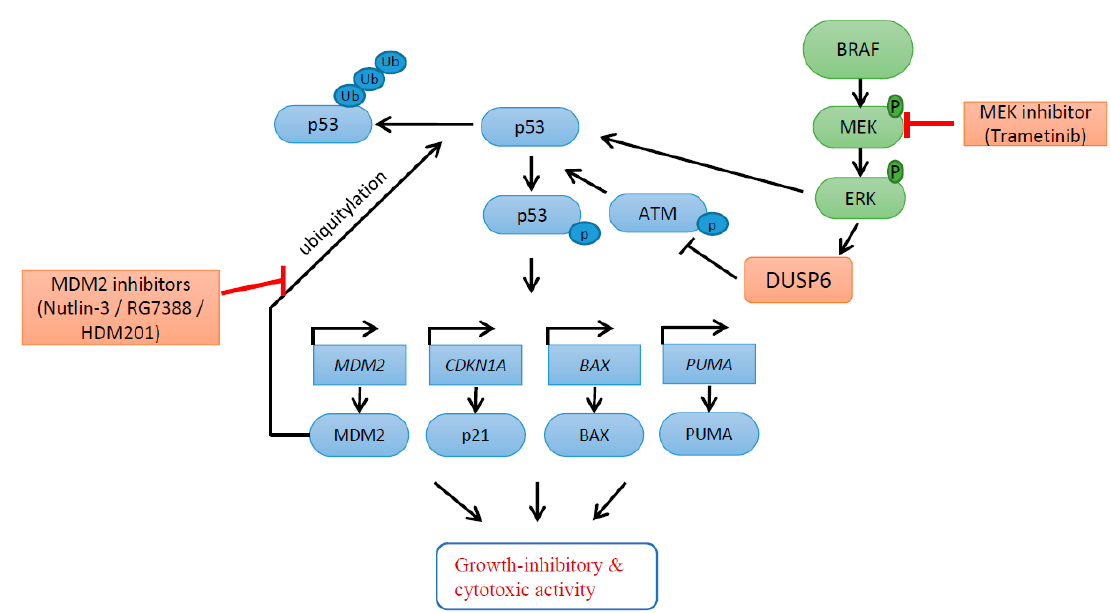
Figure 7. Proposed model involving DUSP6 for response to MEK inhibitor, trametinib, in combination with MDM2 inhibitors. DUSP6 is regulated by ERK rather than p53. Downregulation of DUSP6 by MEK inhibition with trametinib results in loss of DUSP6 phosphatase activity on ATM and consequent increased ATM-mediated phosphorylation of p53 after p53 release by MDM2 inhibitors (nutlin-3/RG7388/HDM201) in BRAF V600E /p53 WT cutaneous melanoma cells. These changes, leading to increased p53 phosphorylation, promote the growth-inhibitory and cytotoxic activity of p53 by increasing p53-dependent transcriptional activity.